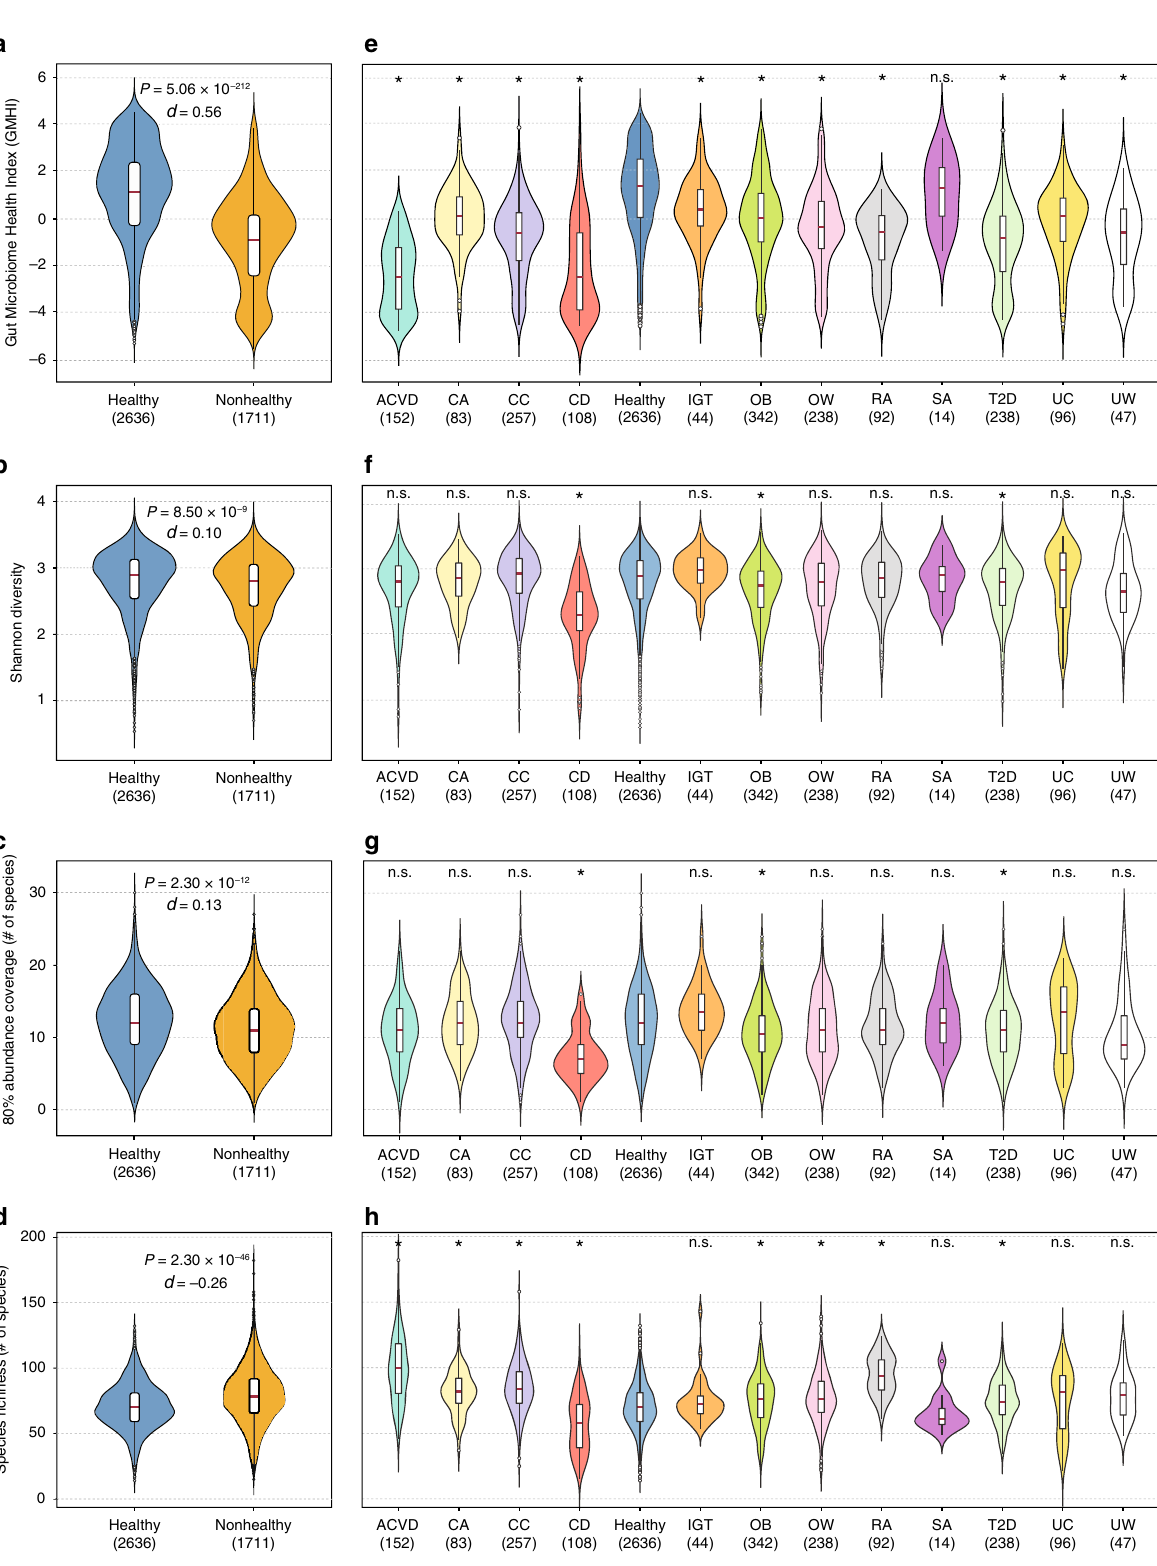
negative) values of GMHI, we observed an increasing proportion of samples from healthy and nonhealthy groups, respectively (Fig. 4a). For example, 98.2% (165 of 168) of metagenome sam- ples with GMHIs >4.0 were from the healthy group; and 81.2% (164 of 202) of metagenome samples with GMHIs < − 4.0 were of nonhealthy origin. In addition, the top 10 to 100 healthy